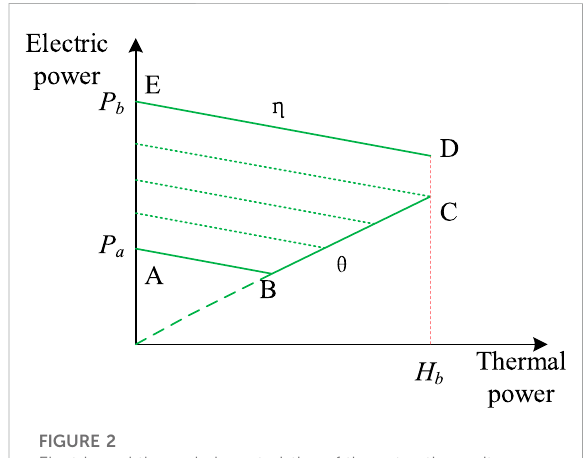
FIGURE 2 Electric and thermal characteristics of the extraction